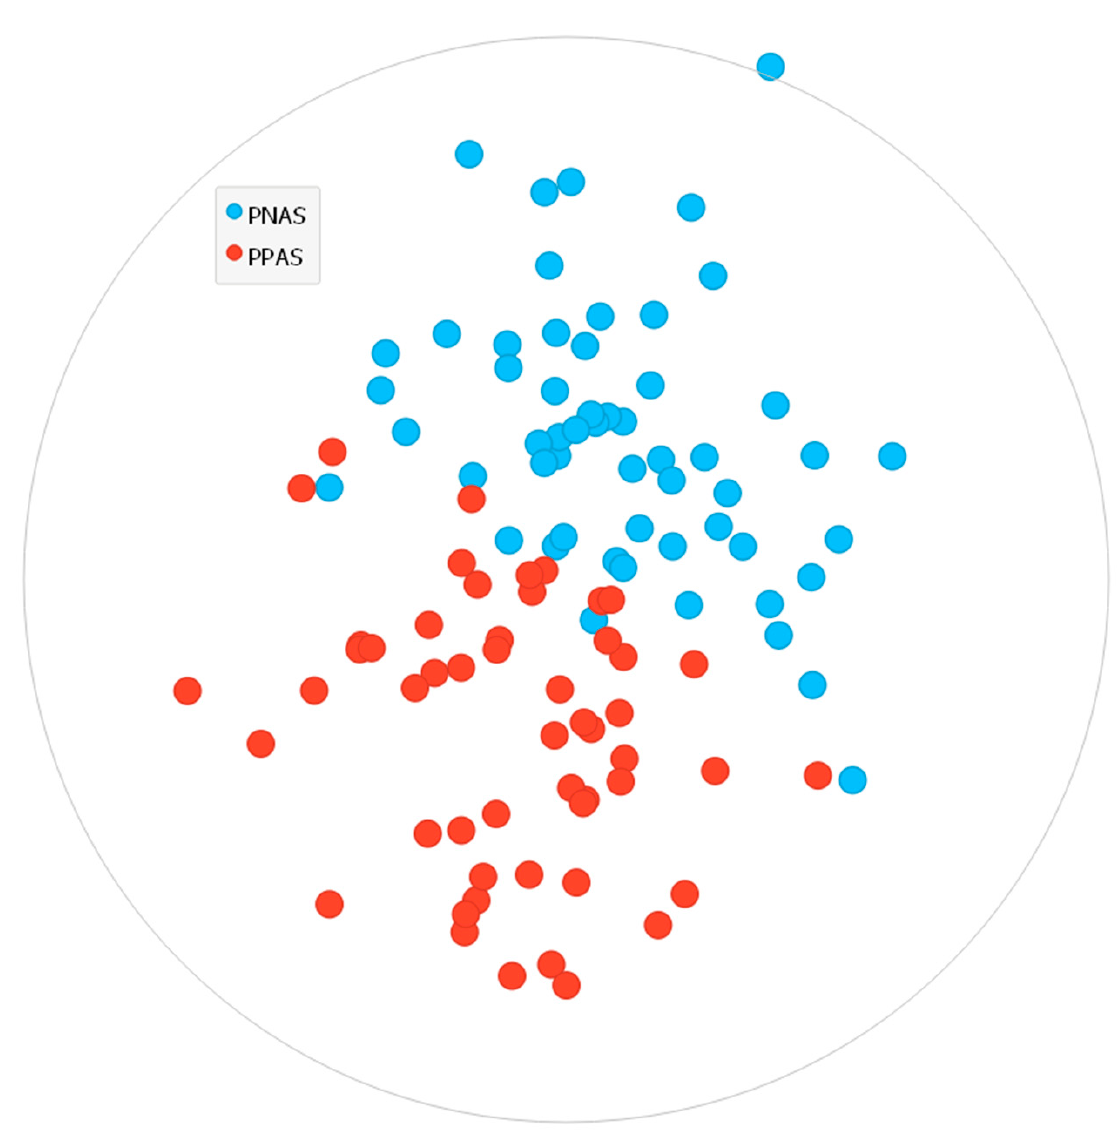
79.12 Note: * = most dominant variables, WHR = Waist hip ratio, PC = principal component. TBW = Total